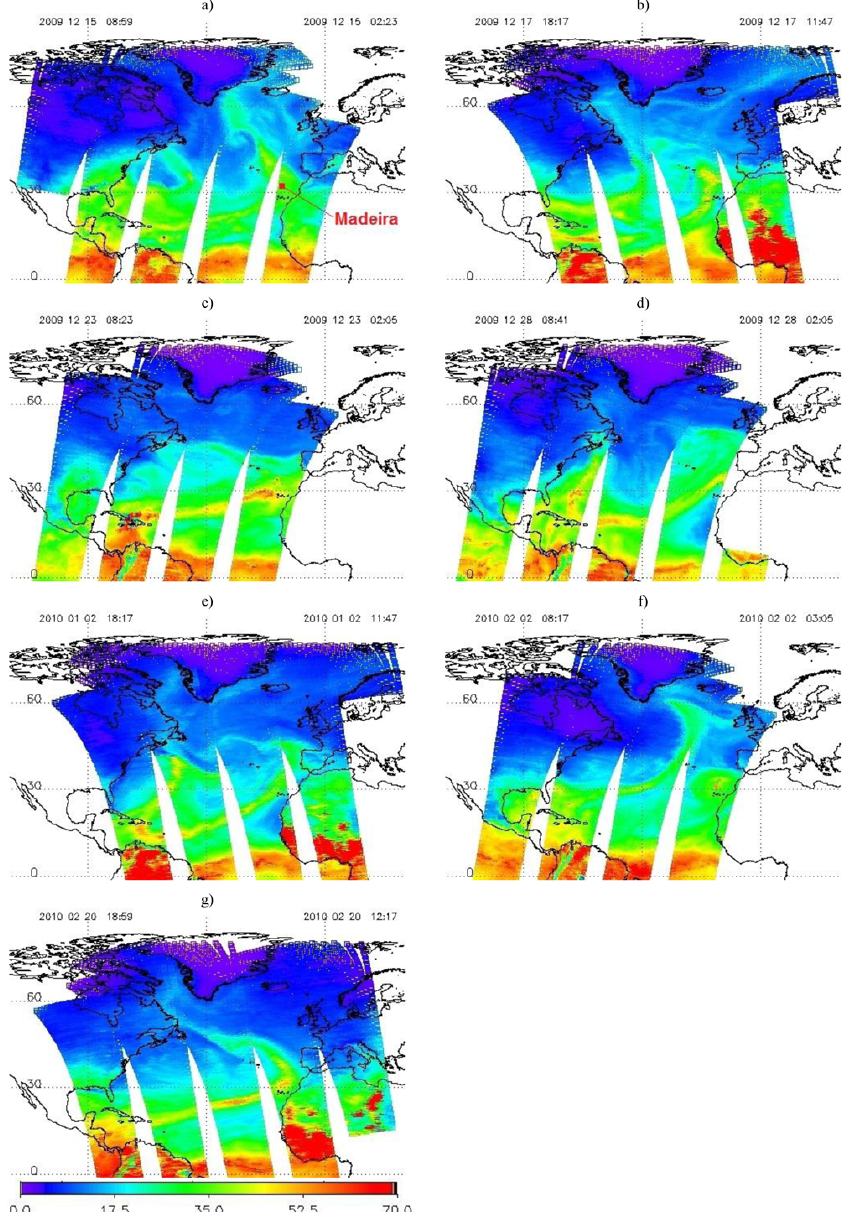
Fig. 4. Satellite images of precipitable water obtained from the Atmospheric InfraRed Sounder (Aqua-AIRS) for each case